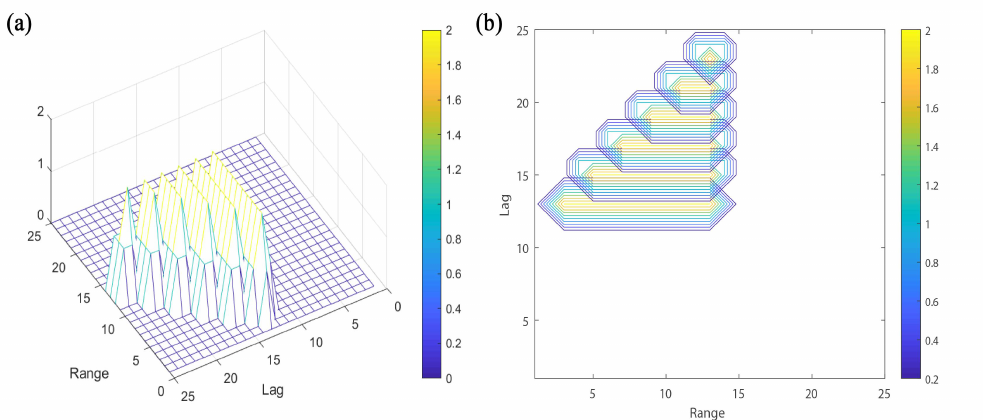
Figure 5. ( a ) TDAF of long pulse and ( b ) corresponding contour